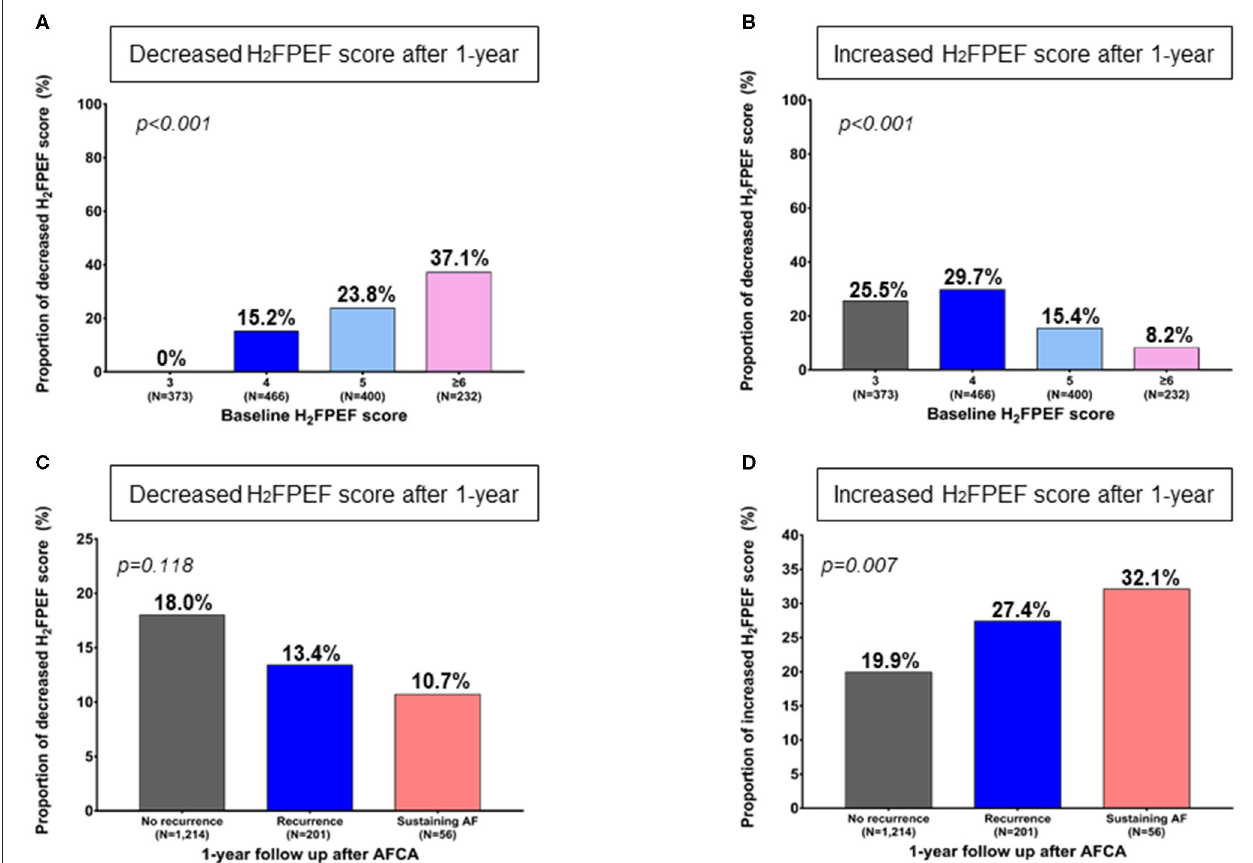
FIGURE 2 | Change in the 1-year H 2 FPEF scores after the AFCA, according to the baseline H 2 FPEF scores (A, B) and rhythm outcomes within a year C, D) . AF, atrial fibrillation; AFCA, atrial fibrillation catheter ablation.